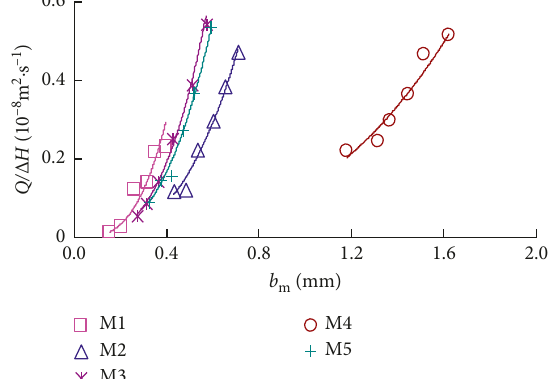
Figure 4: Relationships between flow rate per head and mechanical